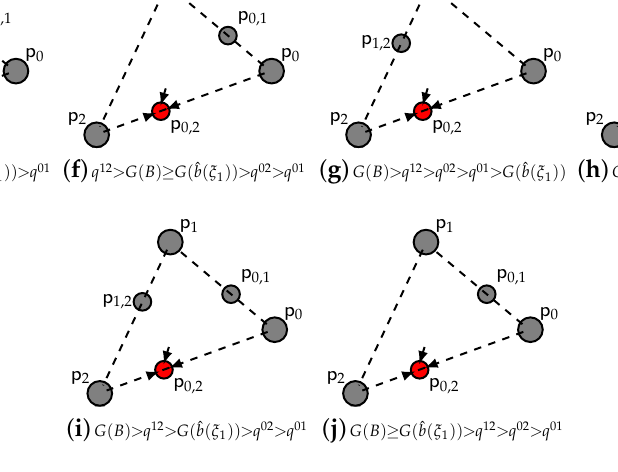
Figure 4. Dynamics for the case of concave f ( (cid:96) ) and three available strategies/ S = { 0,1,2 }